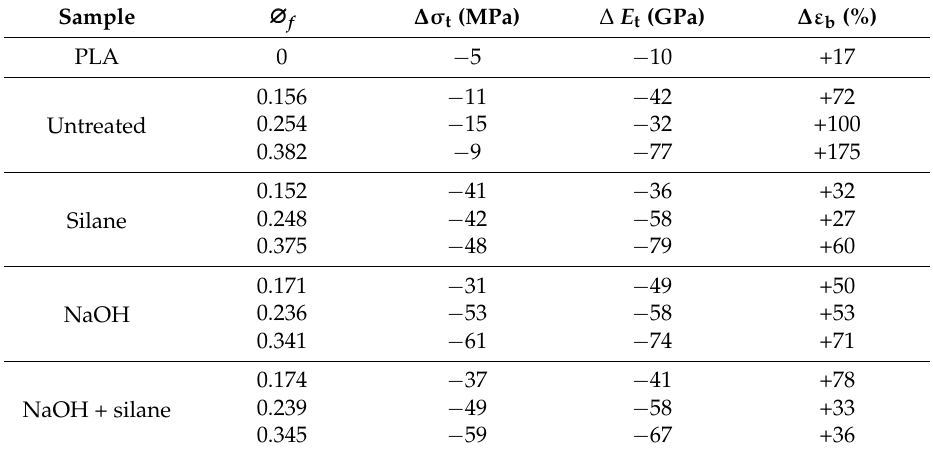
Table 3. Percentage variations of the tensile properties of studied systems after immersion in water.